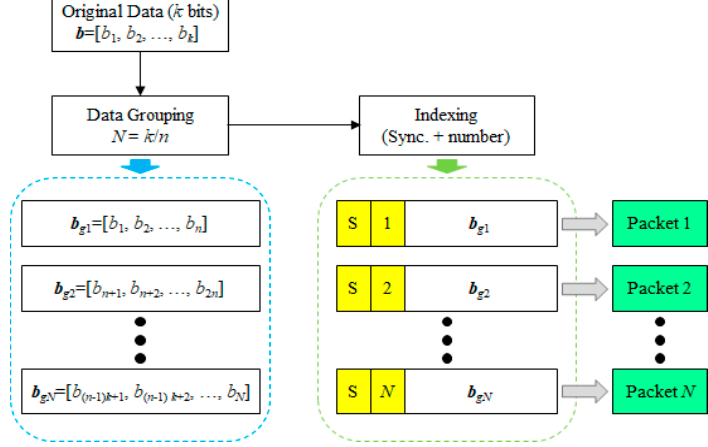
Figure 2. Data fragmentation and indexing structure.